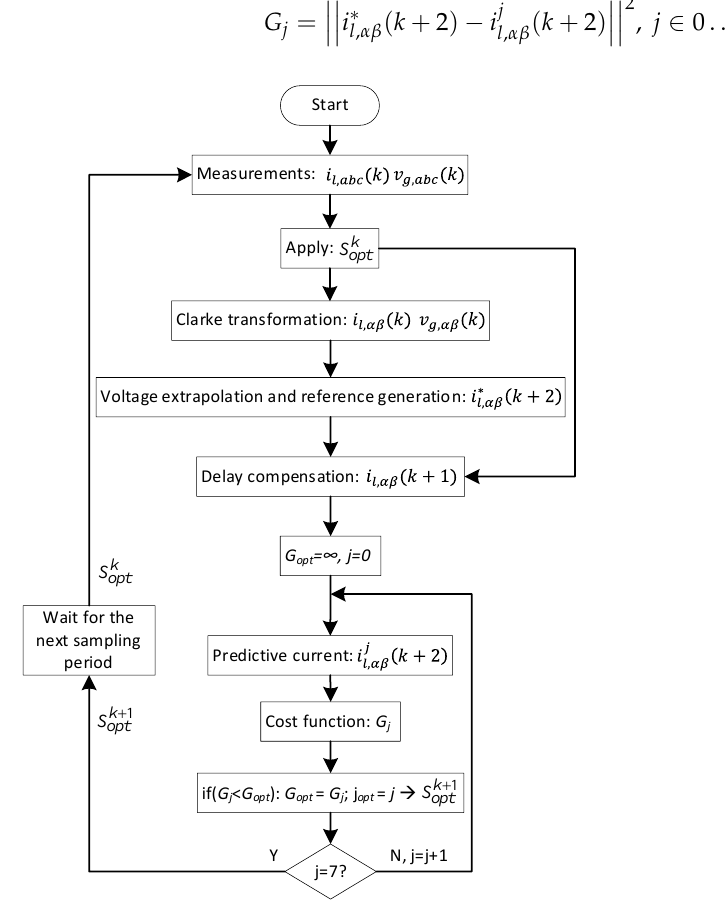
Figure 6. Flowchart of the developed OSV-MPC.